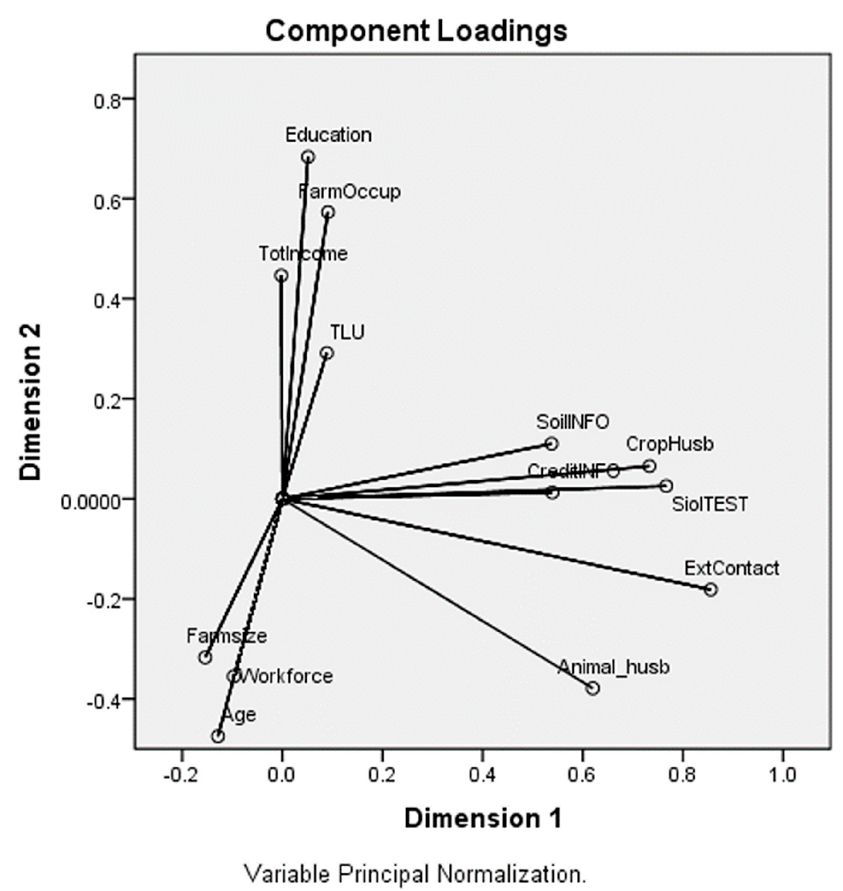
Figure 3. Correlation biplot showing the relationship between socio-economic variables.